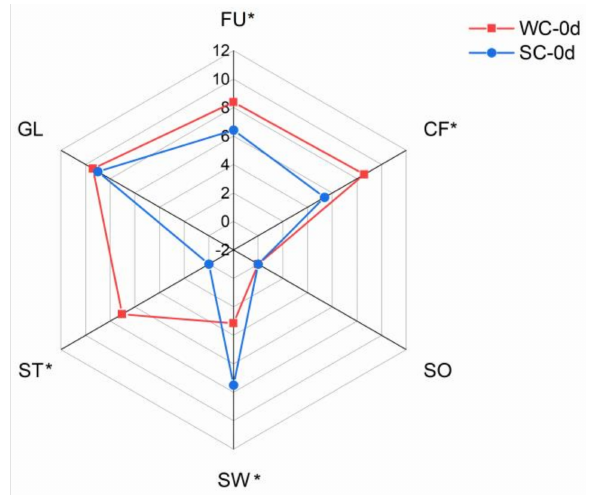
Figure 1. The sensory profile description of two fresh corn sample categories. * indicates that the characteristic indexes significantly differ between the two samples ( p < 0.05). ANOVA was used to analyze differences between groups. WC-0d indicates waxy corn stored for 0 days. SC-0d indicates sweet corn stored for 0 days. FU, CF, SO, SW, ST, and GL indicate that the characteristic sensory qualities of fullness, corn flavor, sourness, sweetness, stickiness, and glossiness,